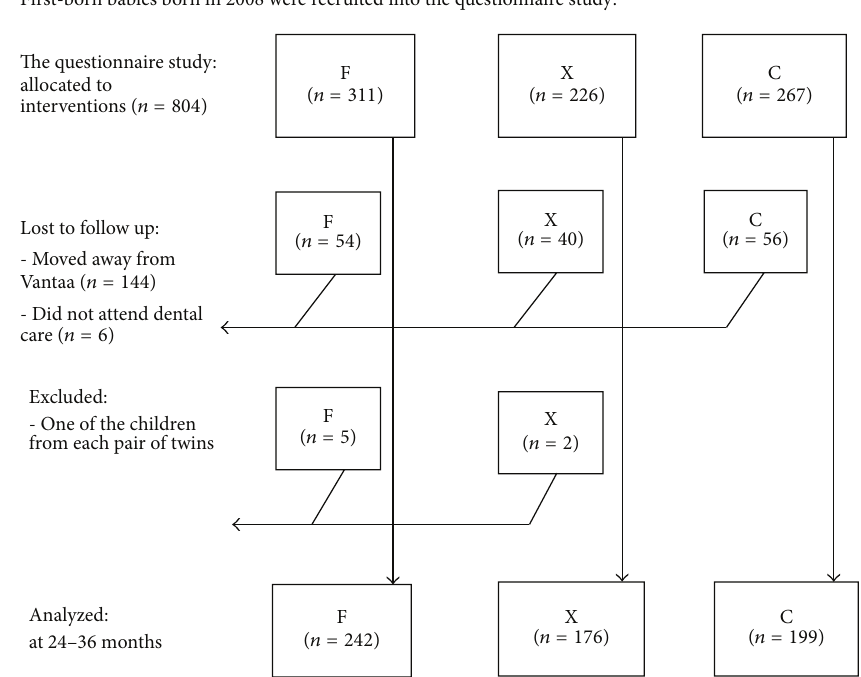
Figure 1: The flow chart: those allocated to interventions, those recruited into the questionnaire study, and those analyzed.